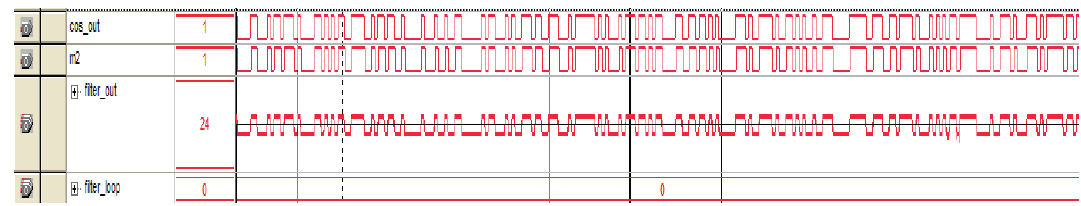
Figure 31. Timing simulation result of the code tracking module.